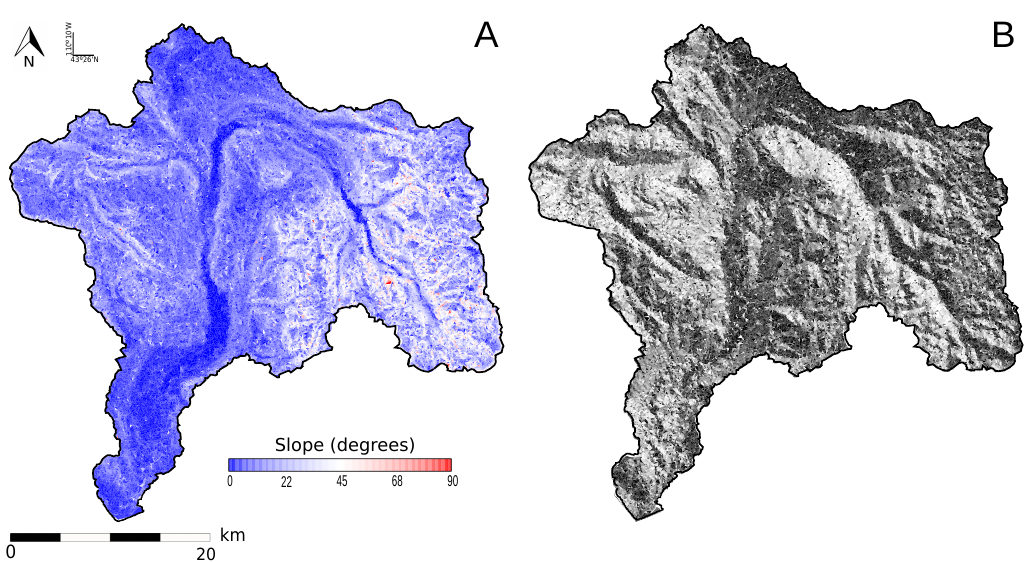
Figure 4. ( A ) Slope degree ( ζ ) and ( B ) slope aspect ( α ), for the Green River Basin. Slope aspects facing north-east are depicted in white while south-west facing slopes are represented black. Flat elements (zero-slope) are depicted in light